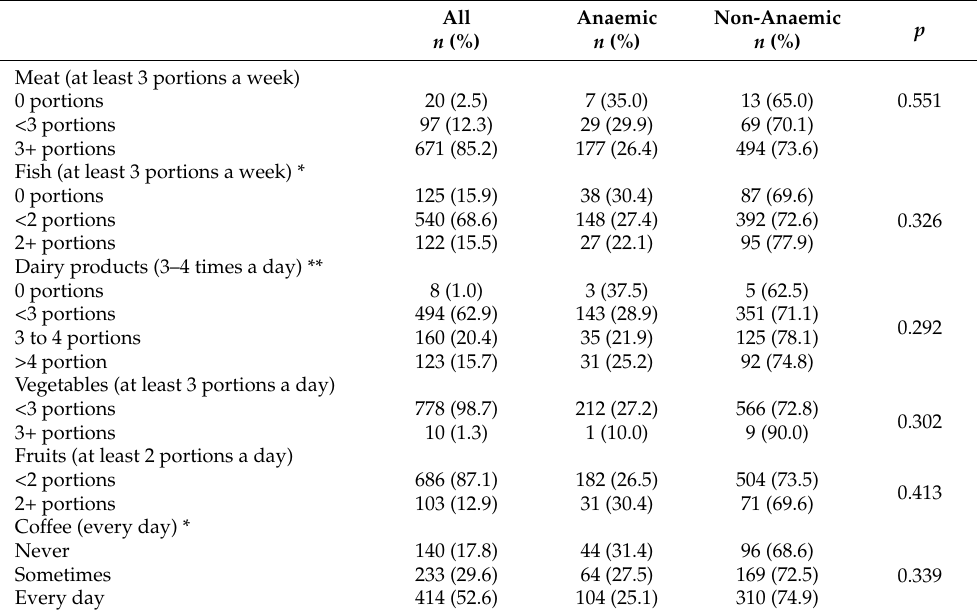
Table 5. Dietary intake according to the prevalence of anaemia in the third trimester of pregnancy ( n =